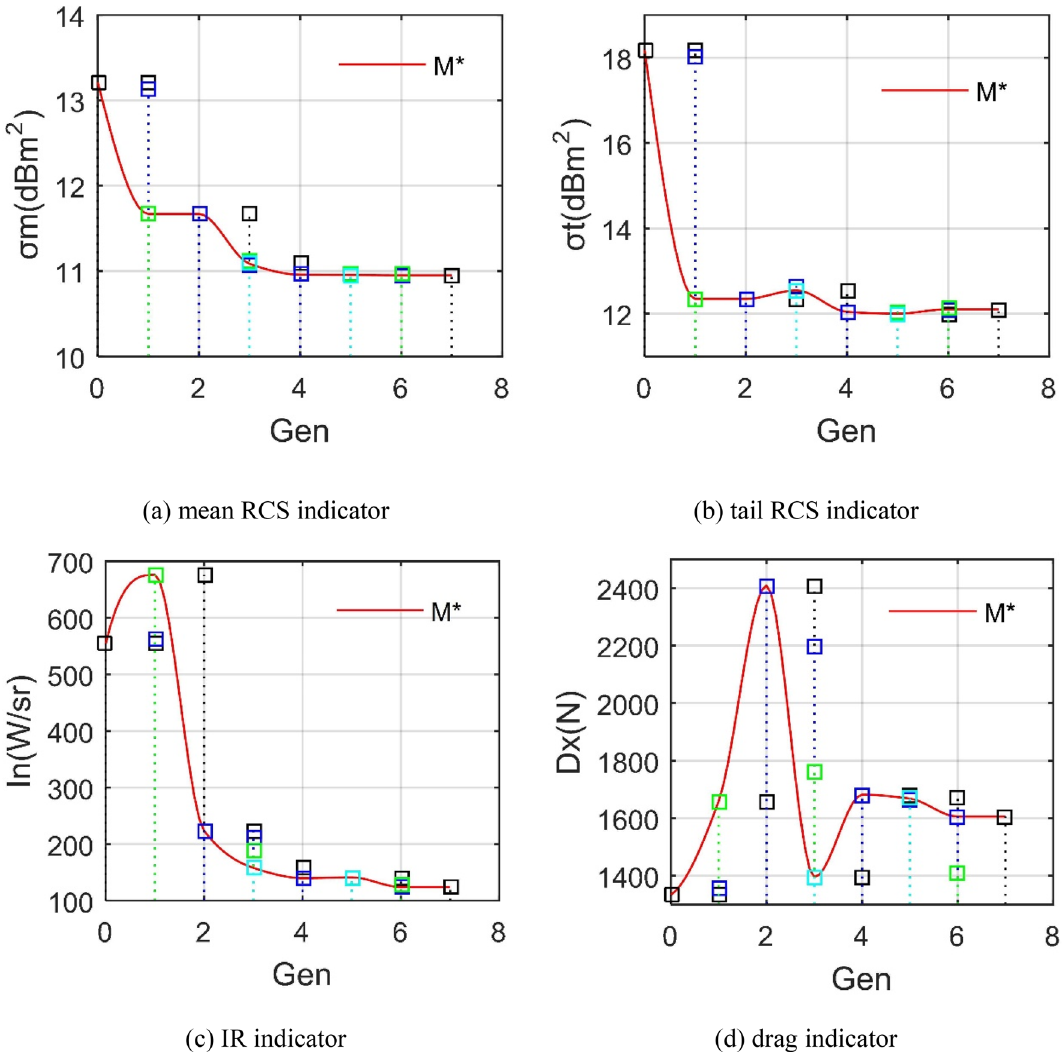
Figure 16. History chart of various performance indicators.